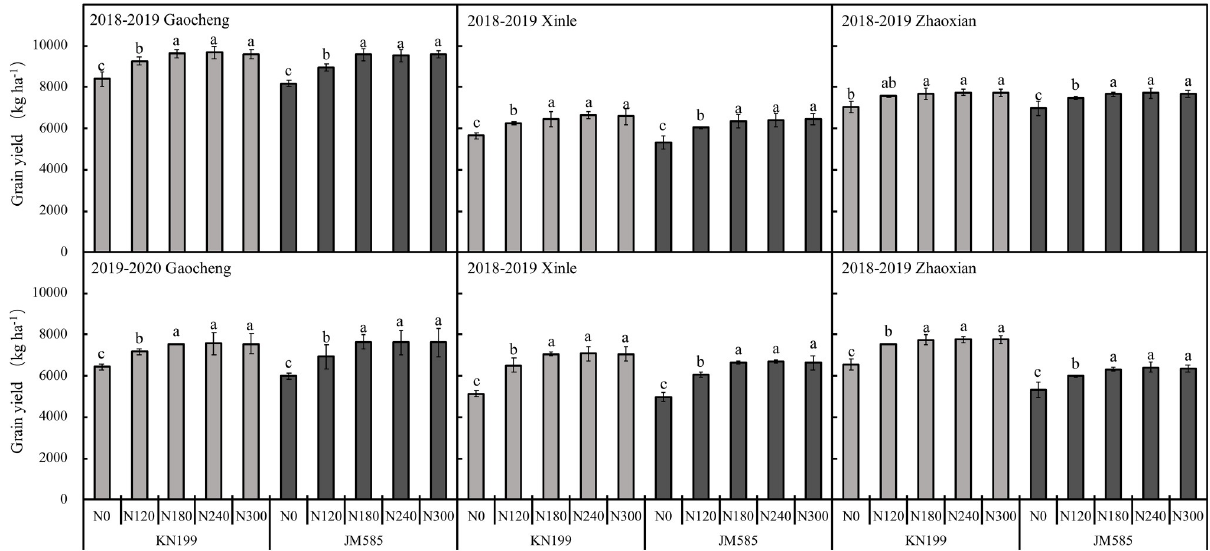
Fig 4. Grain yield of different winter wheat varieties under different nitrogen fertilization rates in three experimental sites during 2018–2020 seasons. Error bars represent one standard deviation from the mean. Letters above the bars are comparison results of leaf area index between different nitrogen treatments of the same variety. There is no significant difference between treatments with same